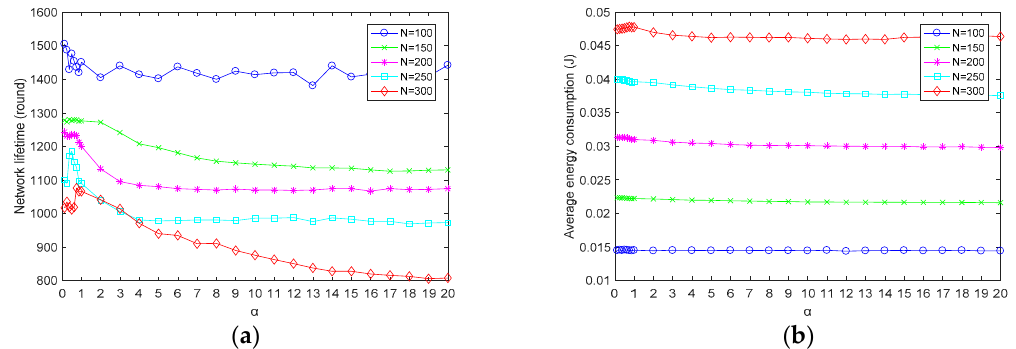
Figure 2. ( a ) Impacts of 𝛼 on network lifetime (NL); ( b ) Impacts of 𝛼 on average energy (AE).